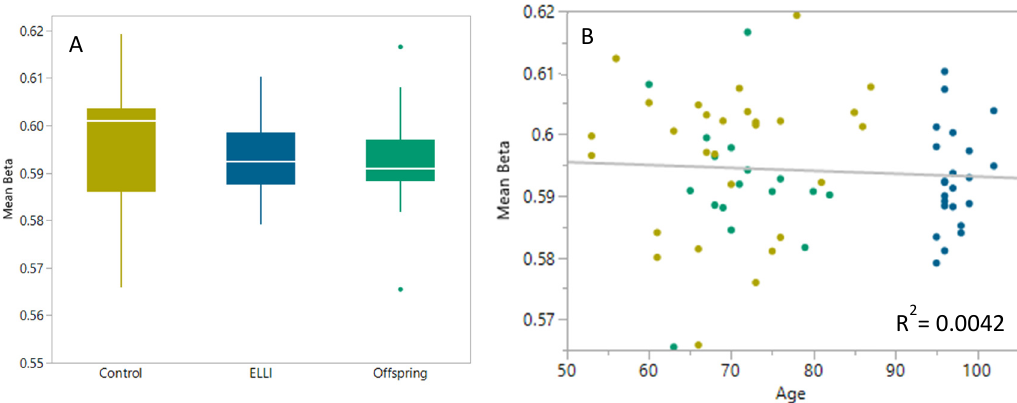
Figure 1. Mean methylation by group. Methylation levels measured via Illumina MethylationEPIC beadchip, converted to beta values with preprocessNoob to remove background read signal through Minfi R package. N control = 28, N ELLI = 24, and N offspring = 17 (one outlier removed). Difference between groups found non-significant by one-way Kruskal–Wallis analysis. ( A ) Mean beta values per group, mean control = 0.596 ± 0.012, mean ELLI = 0.593 ± 0.008, and mean offspring = 0.592 ± 0.011. ( B ) Linear regression of mean beta values over age, non-significant.